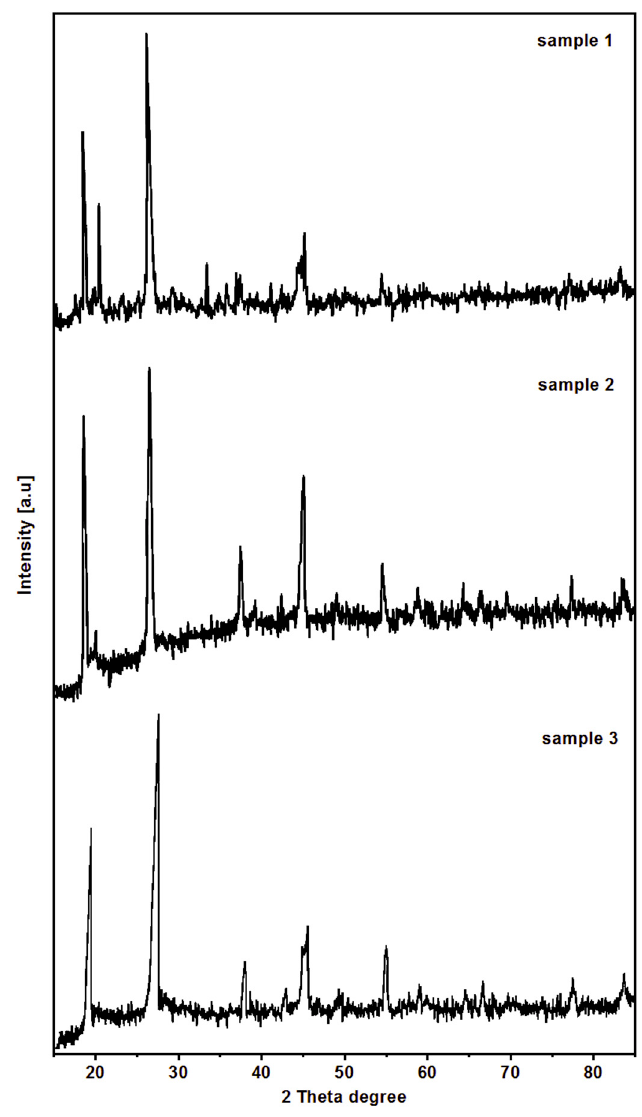
Figure 8. XRD pattern of battery waste powder for sample 1 that was leached with H 2 SO 4 and H 2 O 2 , sample 2 that was leached with H 2 SO 4 and C 5 H 8 O 4 , and sample 3 that was leached with H 2 SO 4 , C 5 H 8 O 4 and H 2 O 2 .